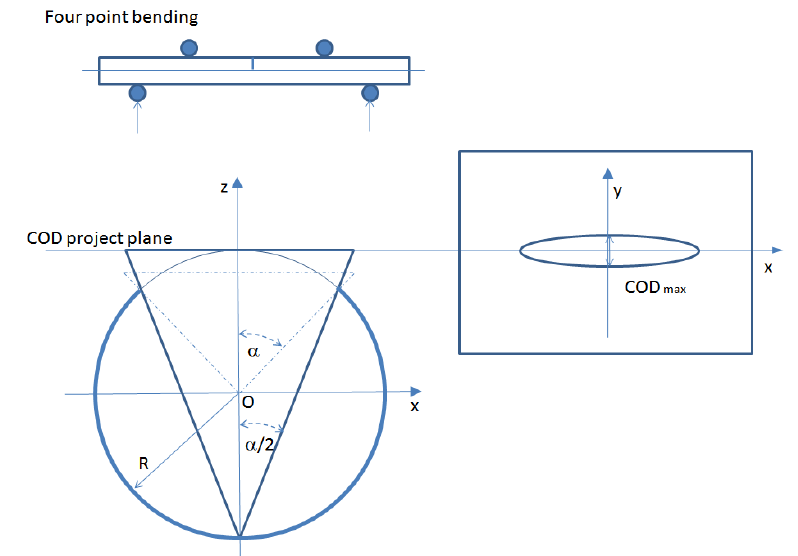
Figure 3: Geometric representation of the hodograph cone for the reference in-axis